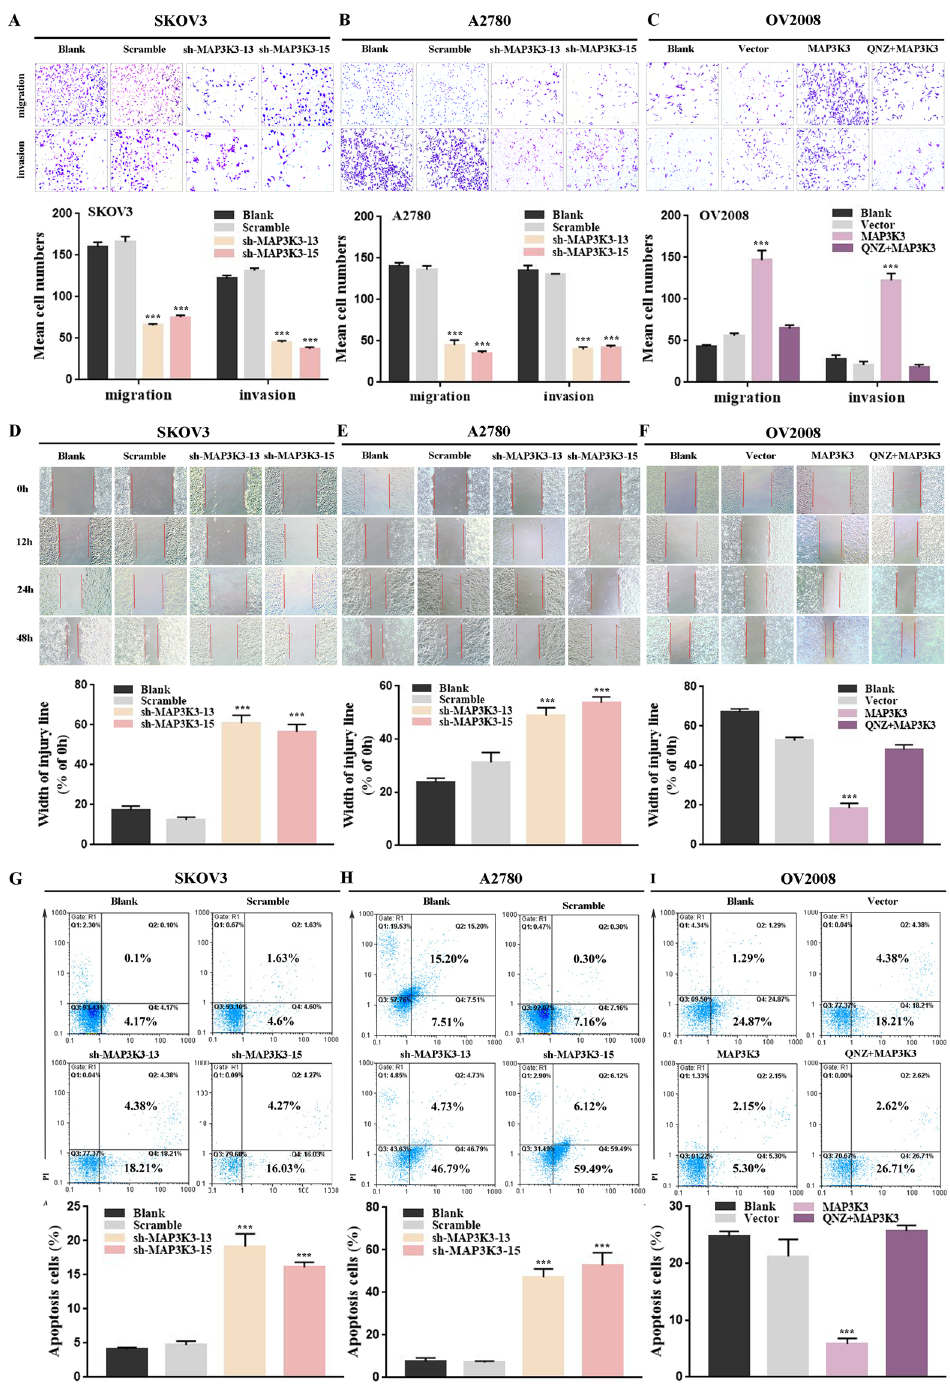
Figure 2. MAP3K3 affected human OC cell migration and apoptosis in vitro . Transwell migration and invasion experiment ( A , B ), cell scratch wound-healing assays ( D , E ), and flow cytometry ( G , H ) to detect the effect of MAP3K3 expression on biological function in SKOV3 and A2780 cells. Effect of MAP3K3 overexpression and blocking the NF- κ B signalling pathway (MAP3K3 + QNZ) in OV2008 cells on cell migration and invasion ( C ), cell motility ( F ), and cell apoptosis ( I ). Repeated three independent experiments, * means p < 0.05, ** means p < 0.01, *** means p <